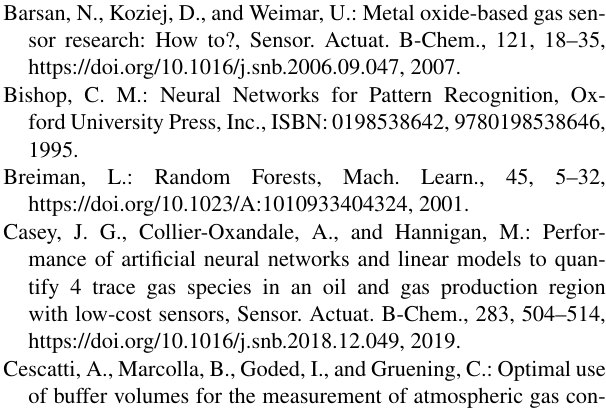
Figaro: TGS 2600 - for the Detection of Air Contaminants, https: //www.figaro.co.jp (last access: 25 June 2022), 2005. Figaro: TGS 2611 - for the detection of Methane, https://www. figaro.co.jp (last access: 25 June 2022),